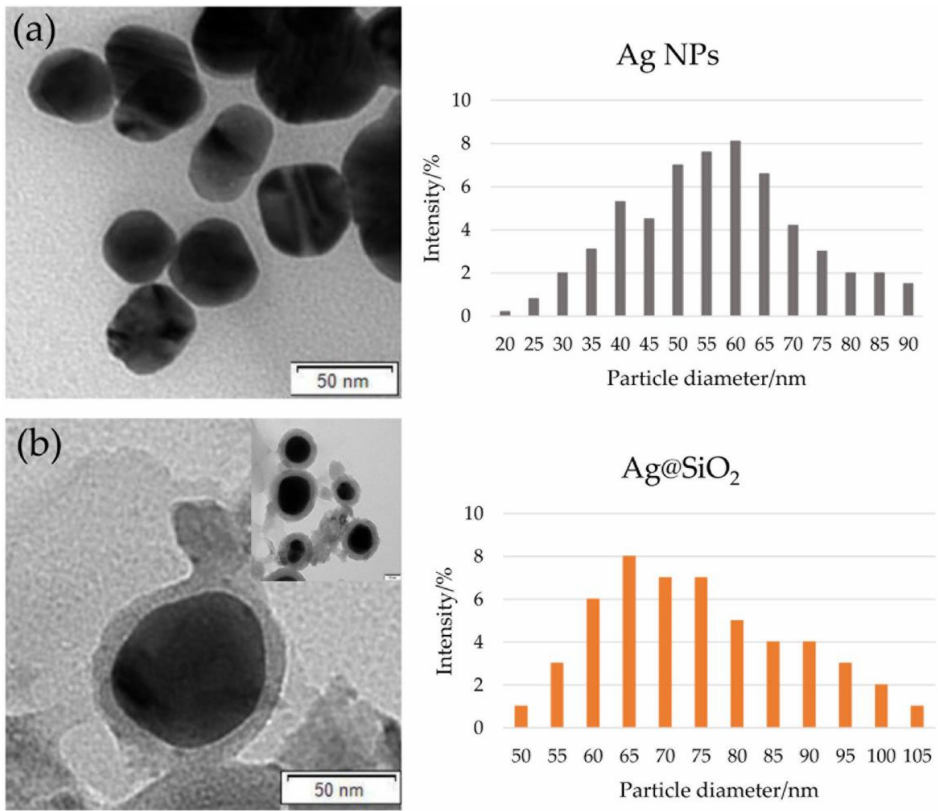
Figure 1. TEM image (left panels) and diagrams of the particle diameter (right panels) obtained for ( a ) Ag NPs and ( b ) Ag@SiO 2